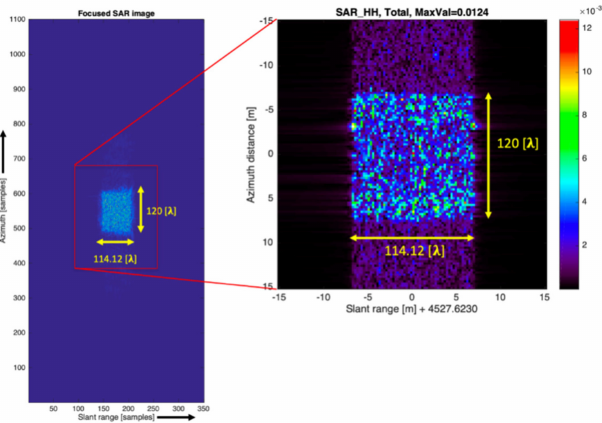
Figure 3. Schematic illustration of the scattering paths due to the incident field upon patches of a scattering body, shown are ( a ) near-field scattering over the scattering body; ( b ) a local coordinate system formed by ( ˆ k i , ˆ n , ˆ t ) . Antenna pattern effect is not shown.